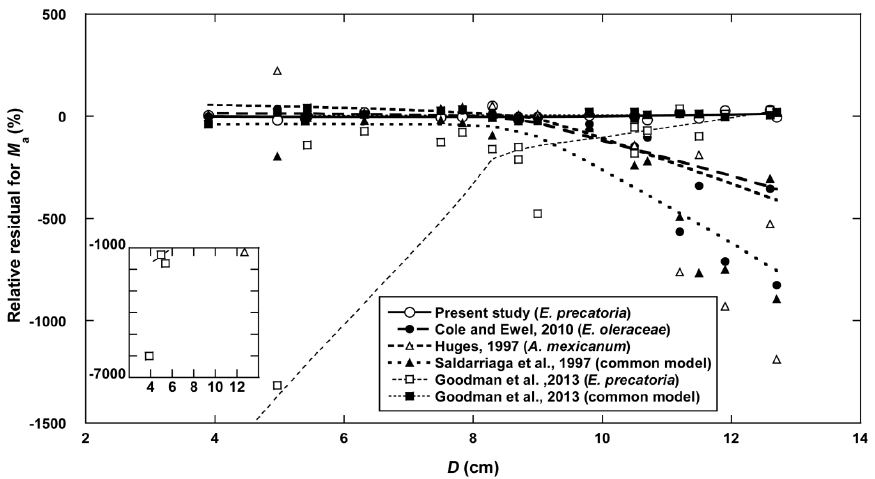
Figure 2. The residuals as percentage are shown for different models for estimating above-ground biomass M a . Open circles and a solid line represent the best model developed in the present study. Closed circles and a long dashed line represent the model developed by Cole and Ewel [16]. Open triangles represent the model developed by Hughes [13]. Closed triangles represent the model developed by Saldarriaga et al. [9]. Open squares represent the model for E. precatoria developed by Goodman et al. [12]. Closed squares represent the common model developed by Goodman et al. [12]. The trend lines corresponding to the models were determined using a lowess procedure (locally weighted scatter plot